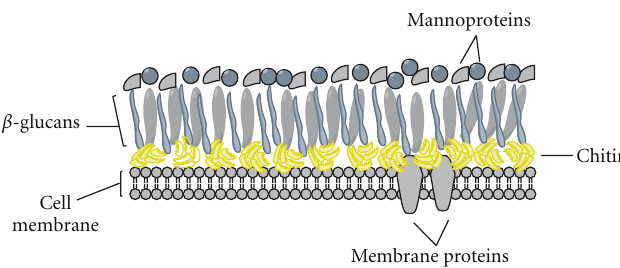
Figure 1: Fungal cell wall components. The fungal cell wall contains a cell membrane with various membrane proteins, a protective layer of chitin (yellow) as well as glucans (mostly beta), and mannoproteins on its surface. Di ff erent fungal cell walls contain di ff erent glucans. For example, the cell wall of A. fumigatus contains β -1,3- and β -1,4-glucan, and α -1,3-glucan [30], while C. albicans contains β -1,3- and β -1,6-glucan [44].